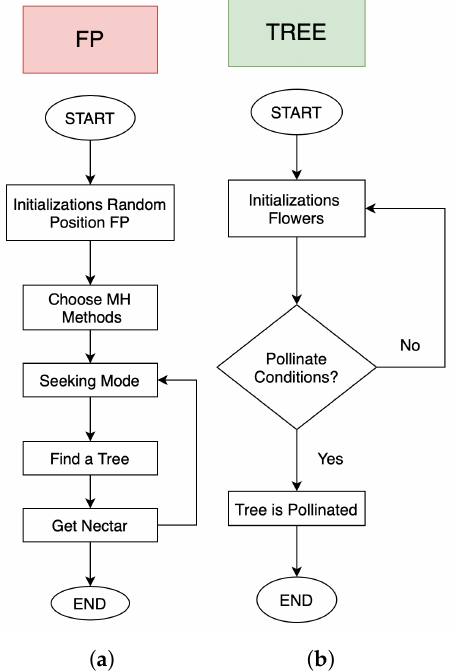
Figure 3. Flowchart of the pollination model used here: ( a ) FP. ( b )